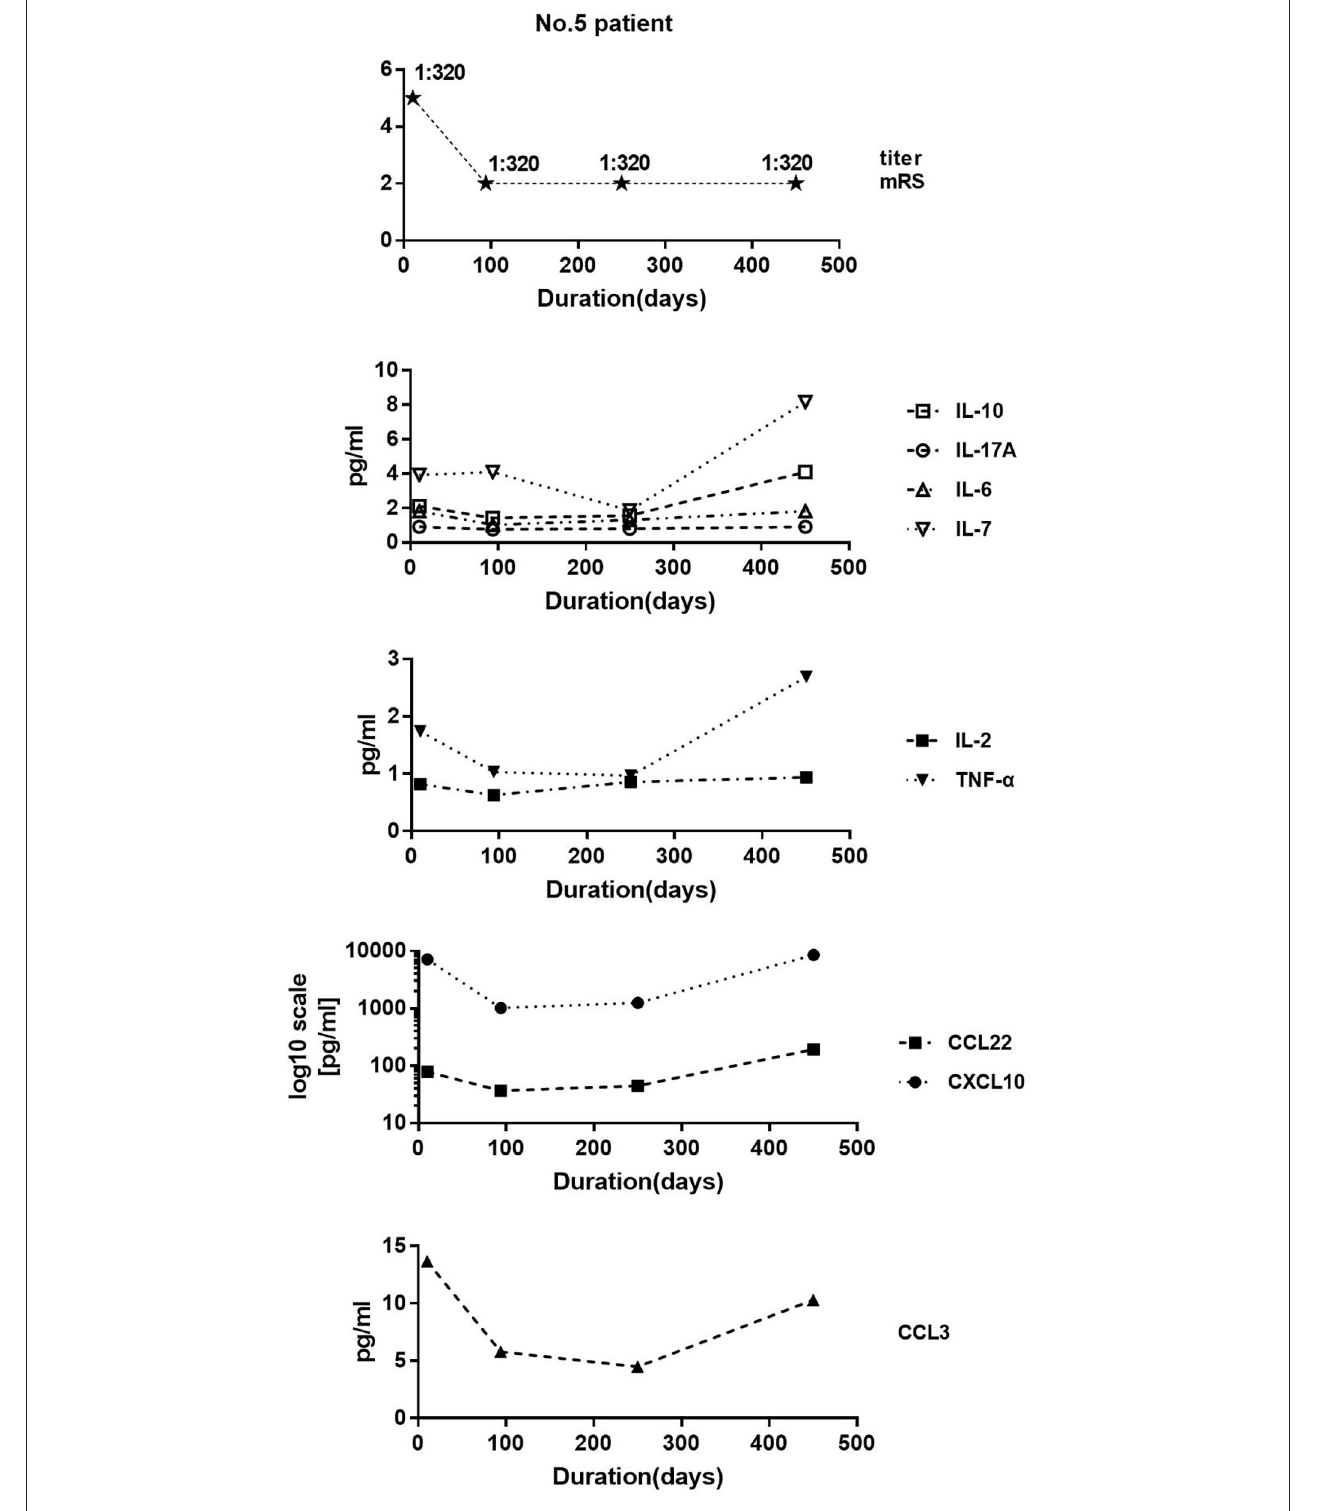
FIGURE 6 | Patient 5 data. We collected four samples at 10, 94, 250, and 450 days after disease onset. Modified Rankin score at these four time points were 5, 2, 2, and 2, respectively. Antibody titer was 1:320, 1:320, 1:320, and 1:320. Clinical symptoms improved on day 94 compared with those on day 10. Despite equal antibody titers in the cerebrospinal fluid, the levels of IL-10, CCL22, IL-17A, IL-2, IL-6, CXCL10, CCL3, and TNF- α decreased.